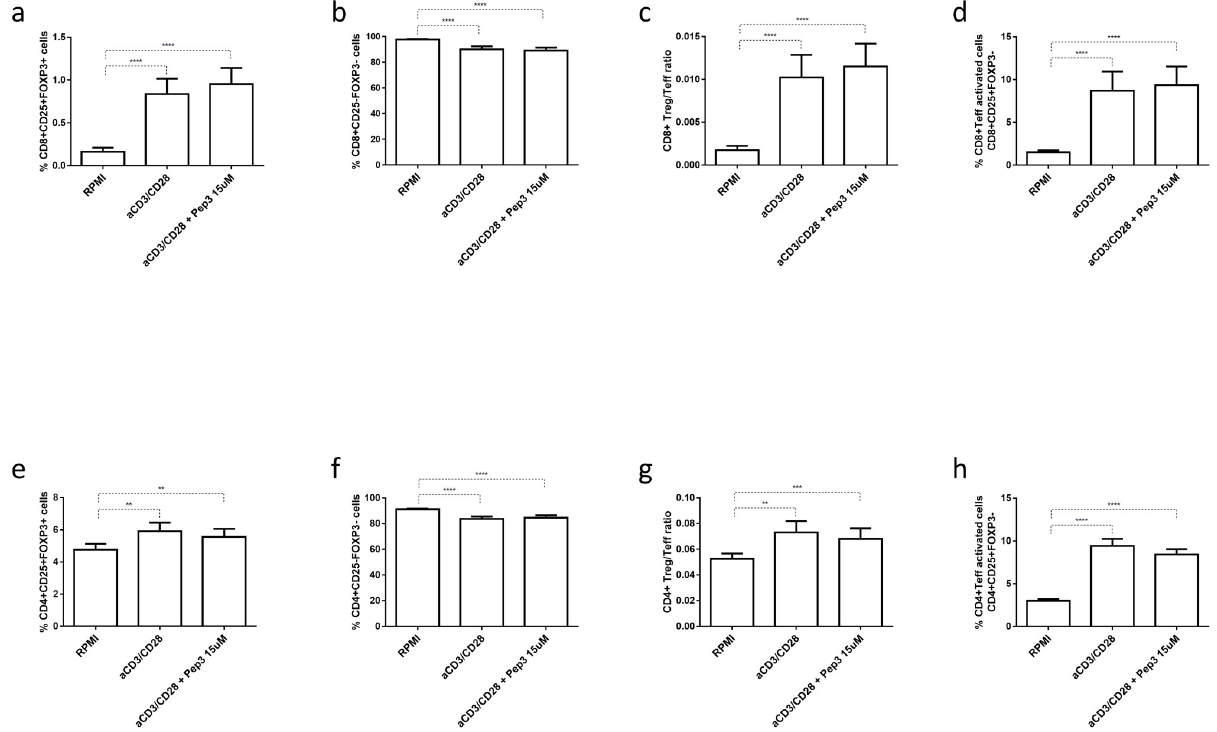
Fig 3. Frequency of T cell populations in PBMC isolated from type 1 diabetes patients treated with peptide 3 and subsequently stimulated with anti-CD3/CD28 beads for 4 days. Flow-cytometry analysis of type 1 diabetes PBMC non-treated non-stimulated (RPMI) or stimulated (anti-CD3/ CD28), treated with 15 μ M Pep3 and subsequently stimulated with anti-CD3/CD28 beads for four days. Percentages were obtained as described for the previous experiments (see legend to Fig 1). Graphs show the percentage of CD8+ Treg as CD8+ CD25+FOXP3+ cells ( a ), CD8+ Teff as CD8+ CD25-FOXP3- cells ( b ), CD8+ Treg/Teff ratio ( c ), CD8+ Teff activated cells as CD8+ CD25+FOXP3- cells ( d ), CD4+ Treg as CD4+ CD25+FOXP3+ cells ( e ), CD4+ Teff as CD4+ CD25-FOXP3- cells ( f ), CD4+ Treg/Teff ratio ( g ), CD4+ Teff activated cells as CD4+ CD25+FOXP3- cells ( h ). Values correspond to mean frequency ± SEM of 16 LT type 1 diabetes patients. �� p < 0.01, ��� p < 0.001, ���� p < 0.0001.